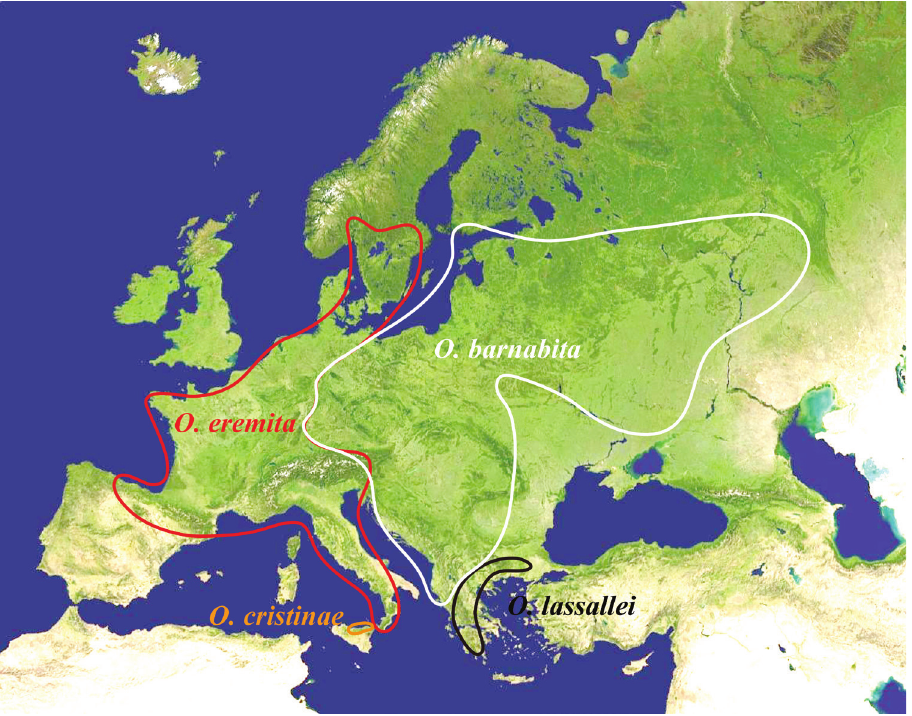
Figure 1. Distribution map of the genus Osmoderma in Europe (from Audisio et al. 2009, modified) (prepared by M.